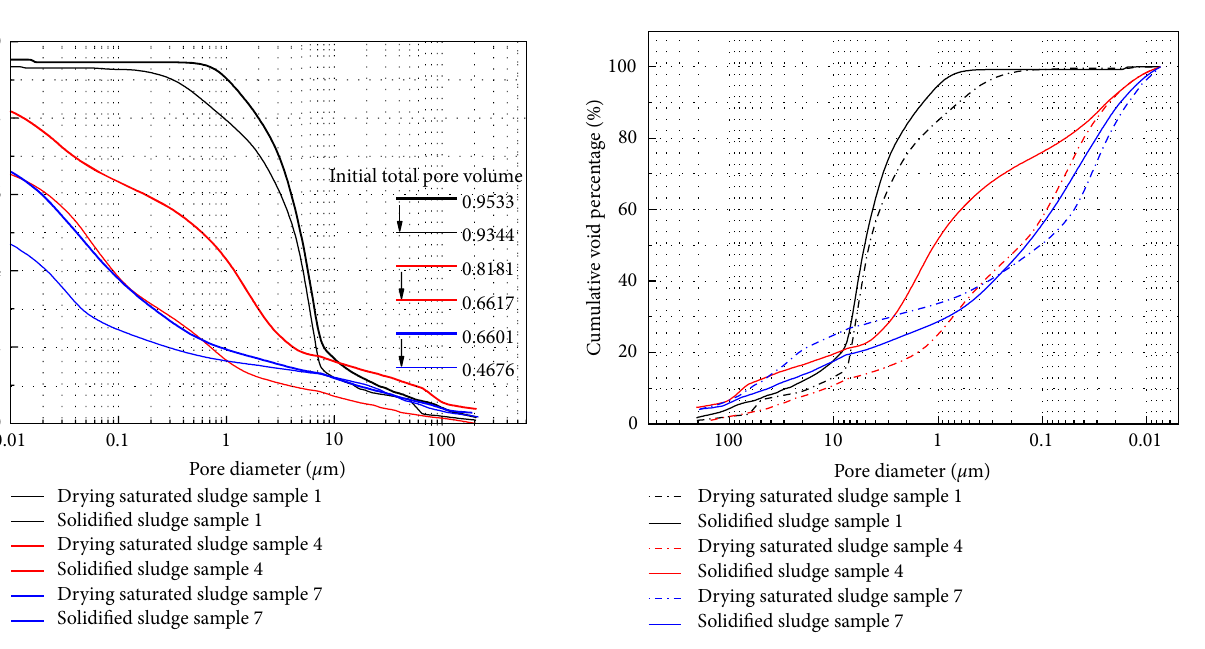
Figure 8: Cumulative porosity percentage of solidified sludge with different initial moisture contents.